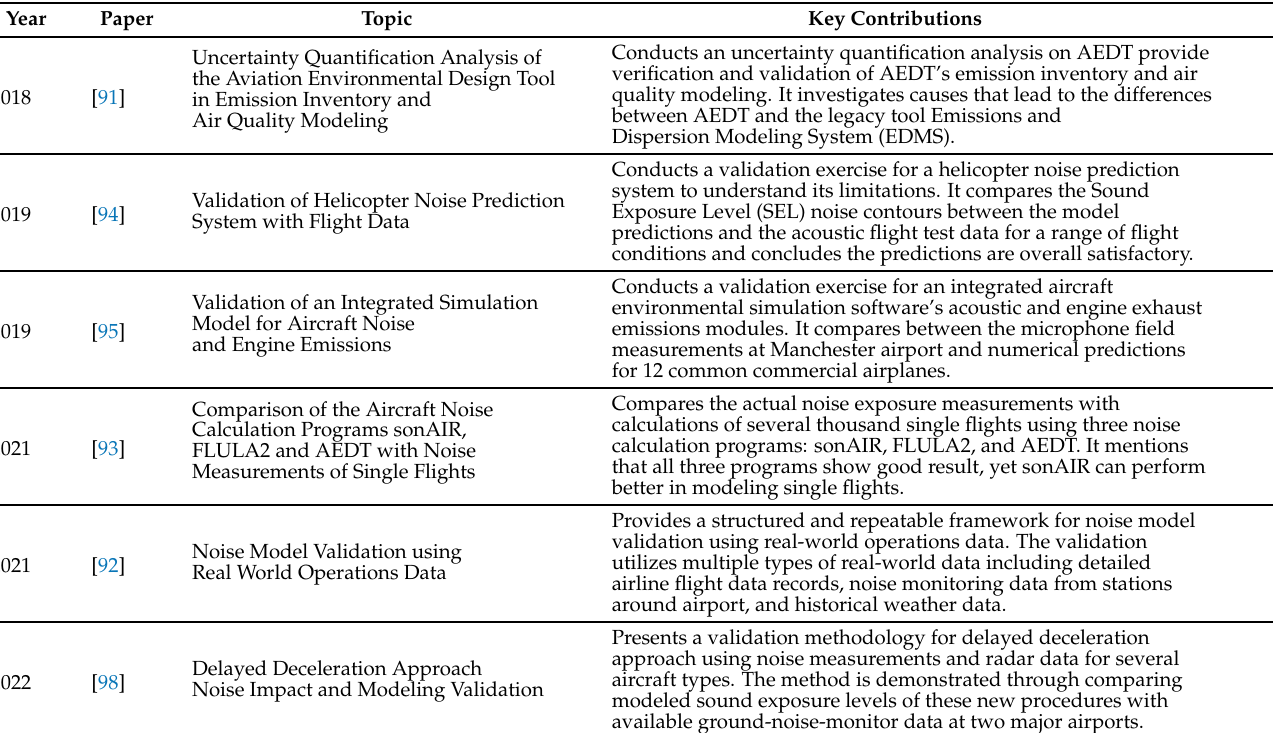
Table 7. Summary of representative papers in verification and